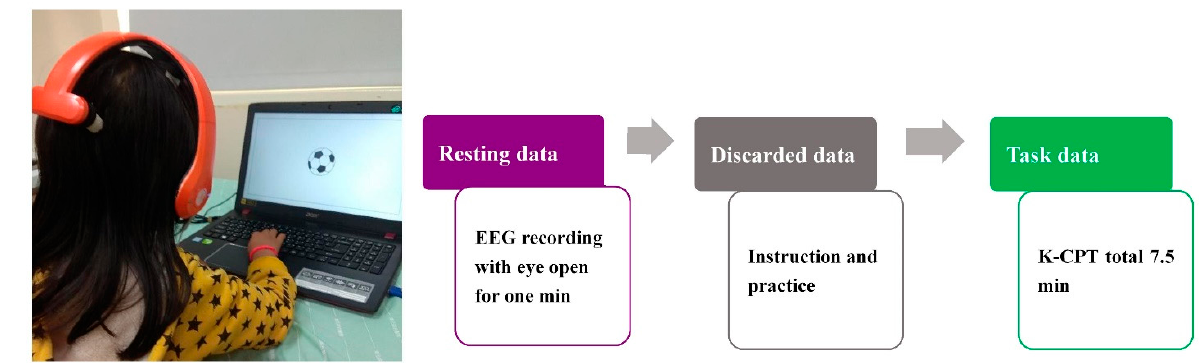
Figure 4. EEG recording